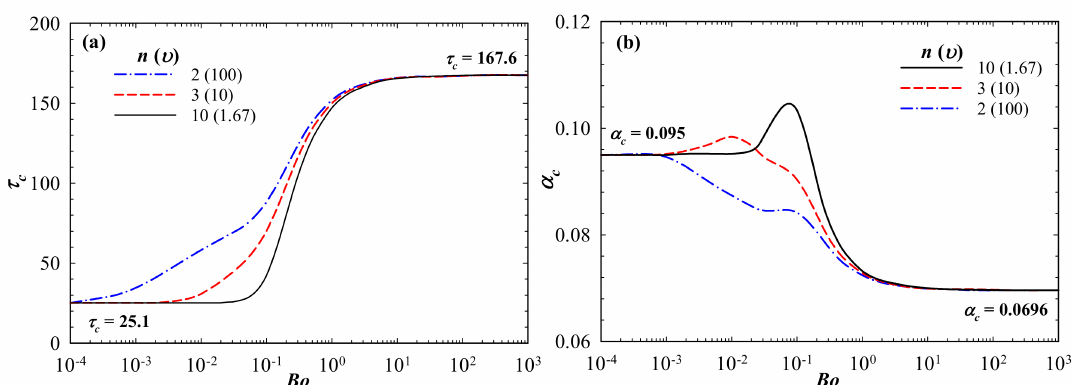
Figure 3. Critical time, τ c , and its corresponding wavenumber, α c , curves vs. Bond number, Bo , for n = 2, 3, and 10. For a particular n , the value of υ was defined in such a way that the normalized wetting phase saturation S at top boundary tends to zero (i.e., S = 0.001). The other parameters are fixed: M = 0.1 and G = 10.